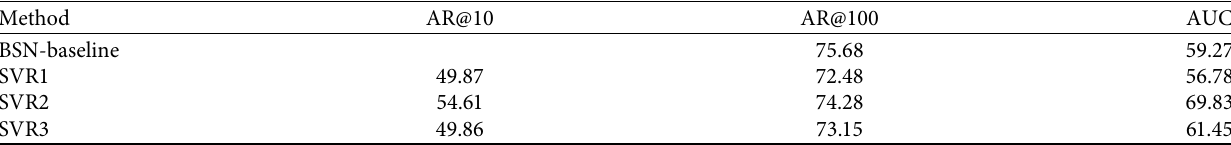
Table 1: SVR experimental process results.